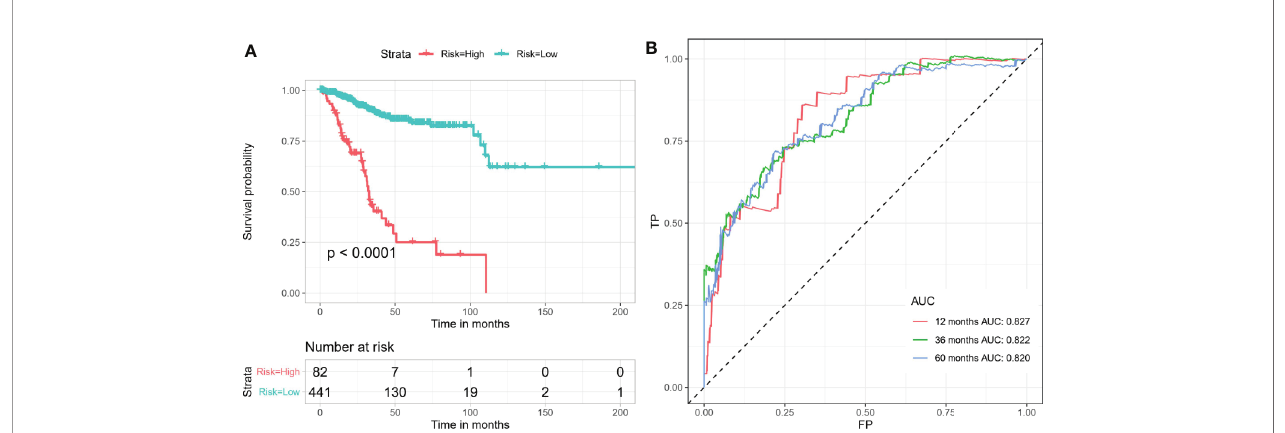
FIGURE 5 | The 16 OS-related DEAS events signatures associated with risk score predicts EC patients ’ OS. (A) K-M survival curve to test the predictive effect of the gene signature. (B) ROC curve analysis to evaluate the sensitivity and speci fi city of the gene signature.